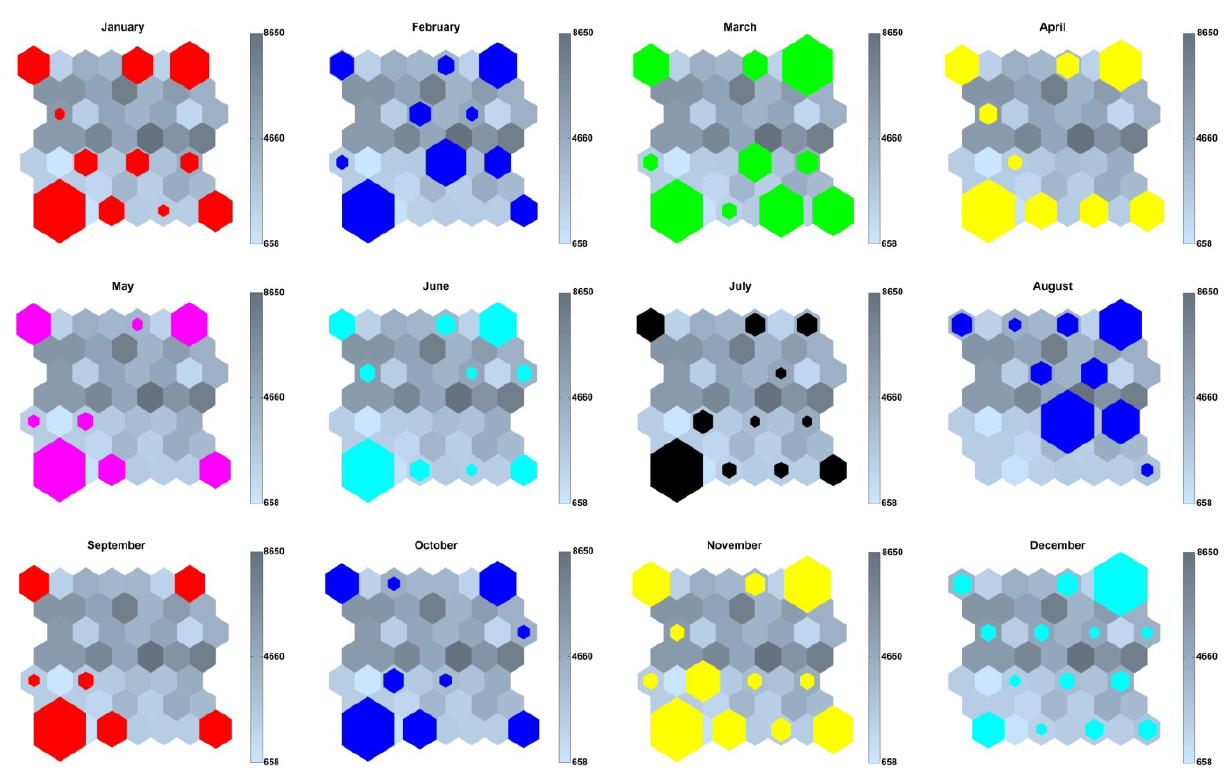
Figure 5. Activation map for